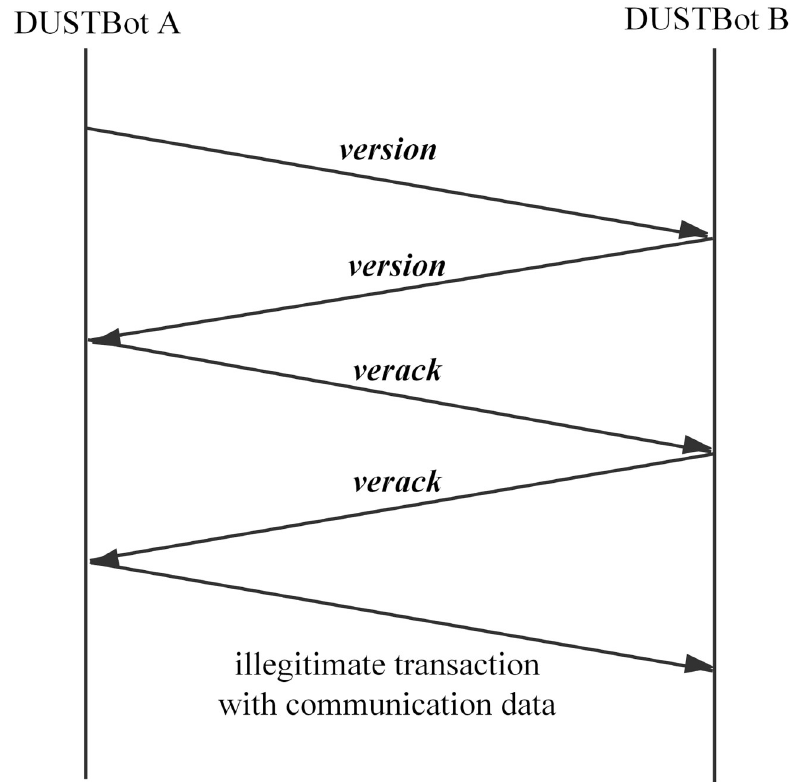
Fig 4. The disguised Version